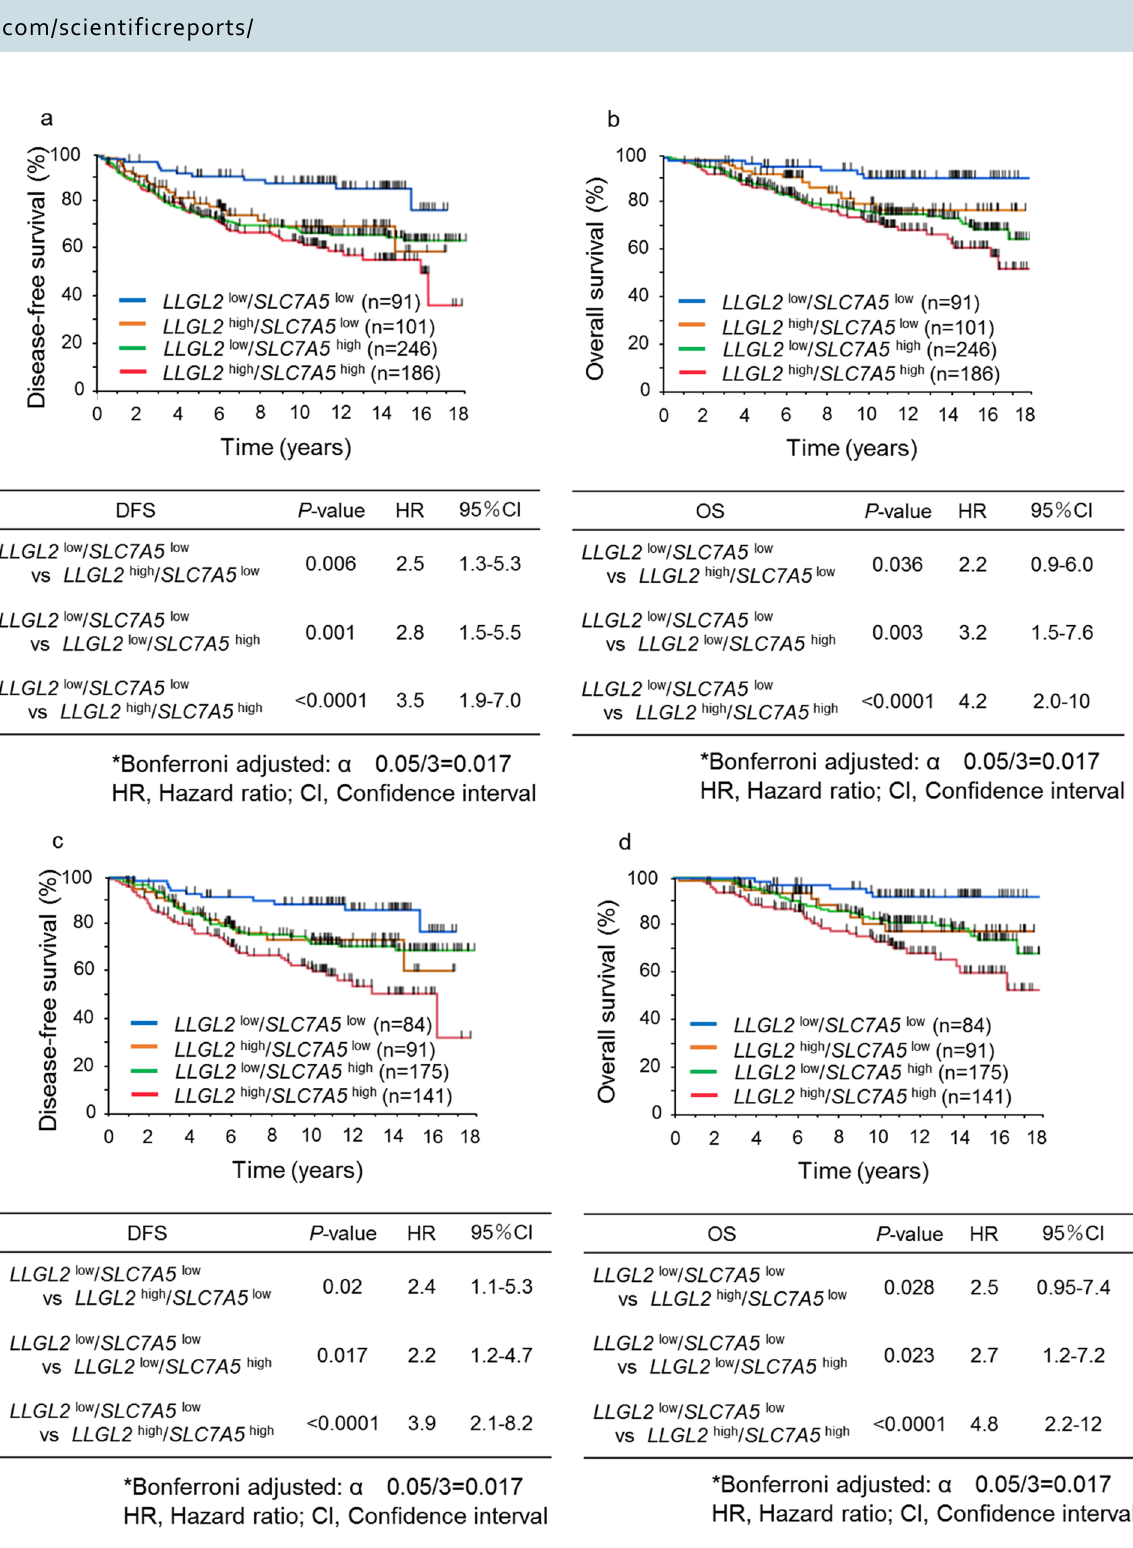
Figure 1. Kaplan–Meier survival curves according to the combination of LLGL2 and SLC7A5 mRNA expression. Graphs show DFS and OS curves for all breast cancer patients ( a,b ), ERα-positive breast cancer patients ( c,d ), ERα-positive breast cancer patients receiving adjuvant tamoxifen therapy ( e,f ), and ERα-negative breast cancer patients ( g,h